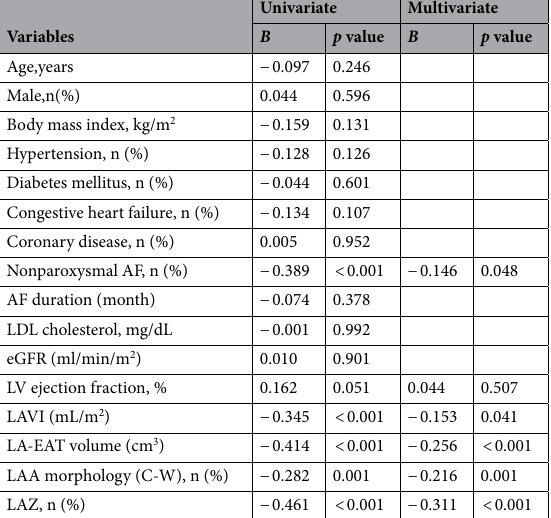
Table 3. Univariate linear regression analyses and multivariate linear regression analysis of Left Atrial Appendage Flow Velocity. AF, atrial fibrillation; LDL-C, Low-density lipoprotein; LV, left ventricular; LAVI, left atrial volume index; LA, left atrial; EAT, Epicardial adipose tissue; LAA, Left atrial appendage; C-W, chicken- wing type; LVZ, low-voltage